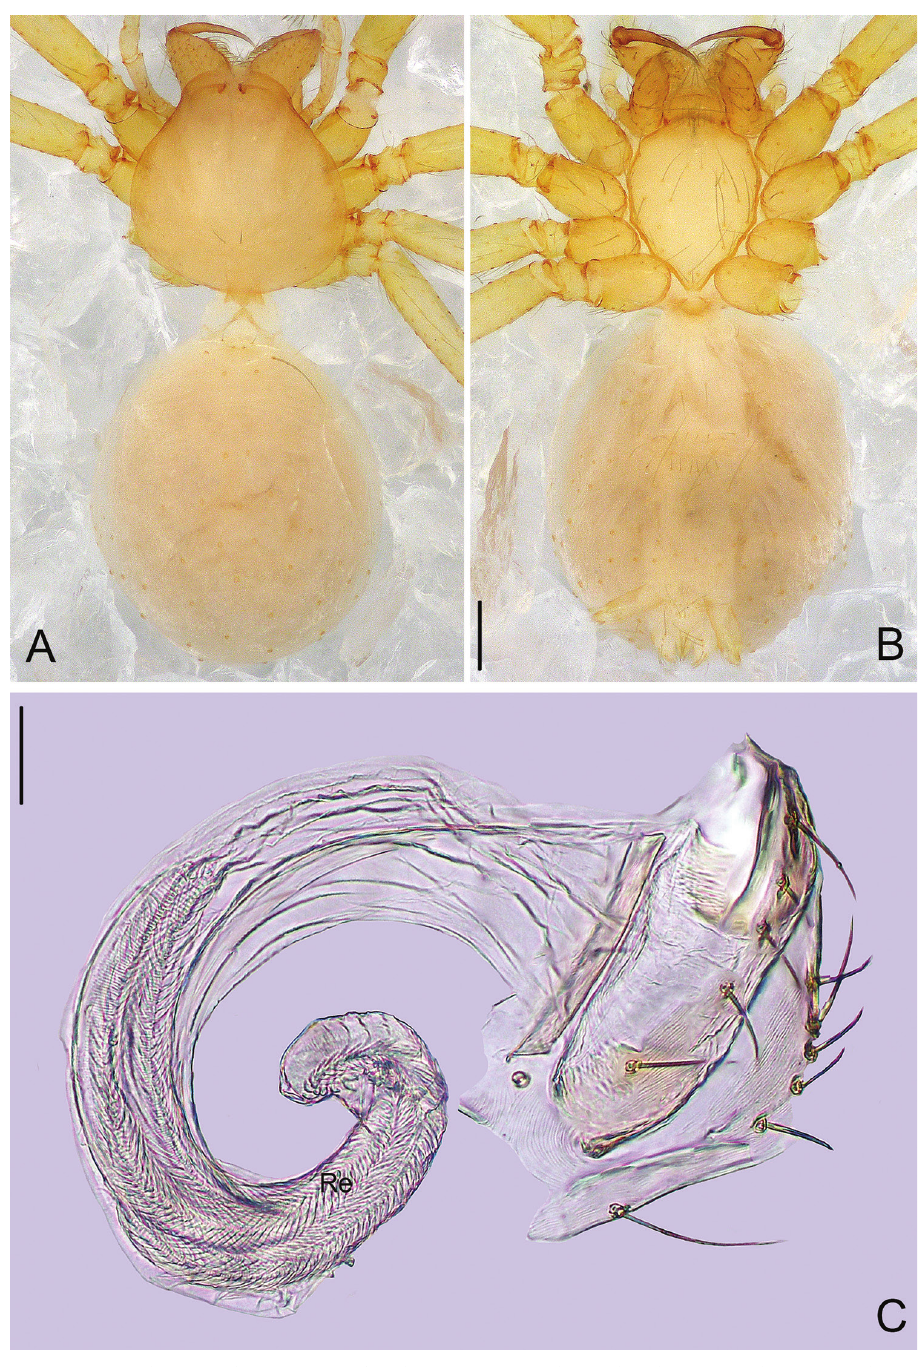
Figure 6. Pinelema qingfengensis sp. n., female paratype. A Habitus, dorsal view B Habitus, ventral view C Vulva, lateral view. Scale bars: 0.2 mm ( A–B ), 0.05 mm ( C